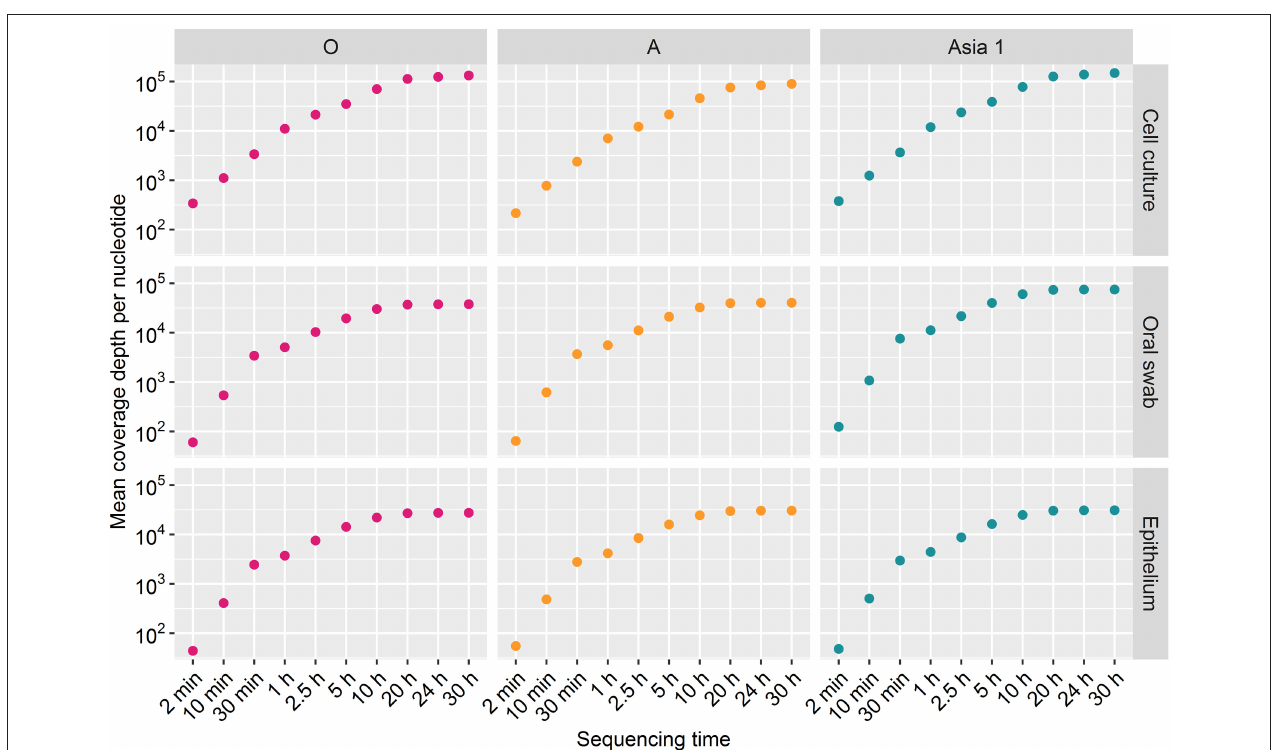
FIGURE 3 | The mean coverage per nucleotide for each sample tested over the duration of the MinION sequencing runs.